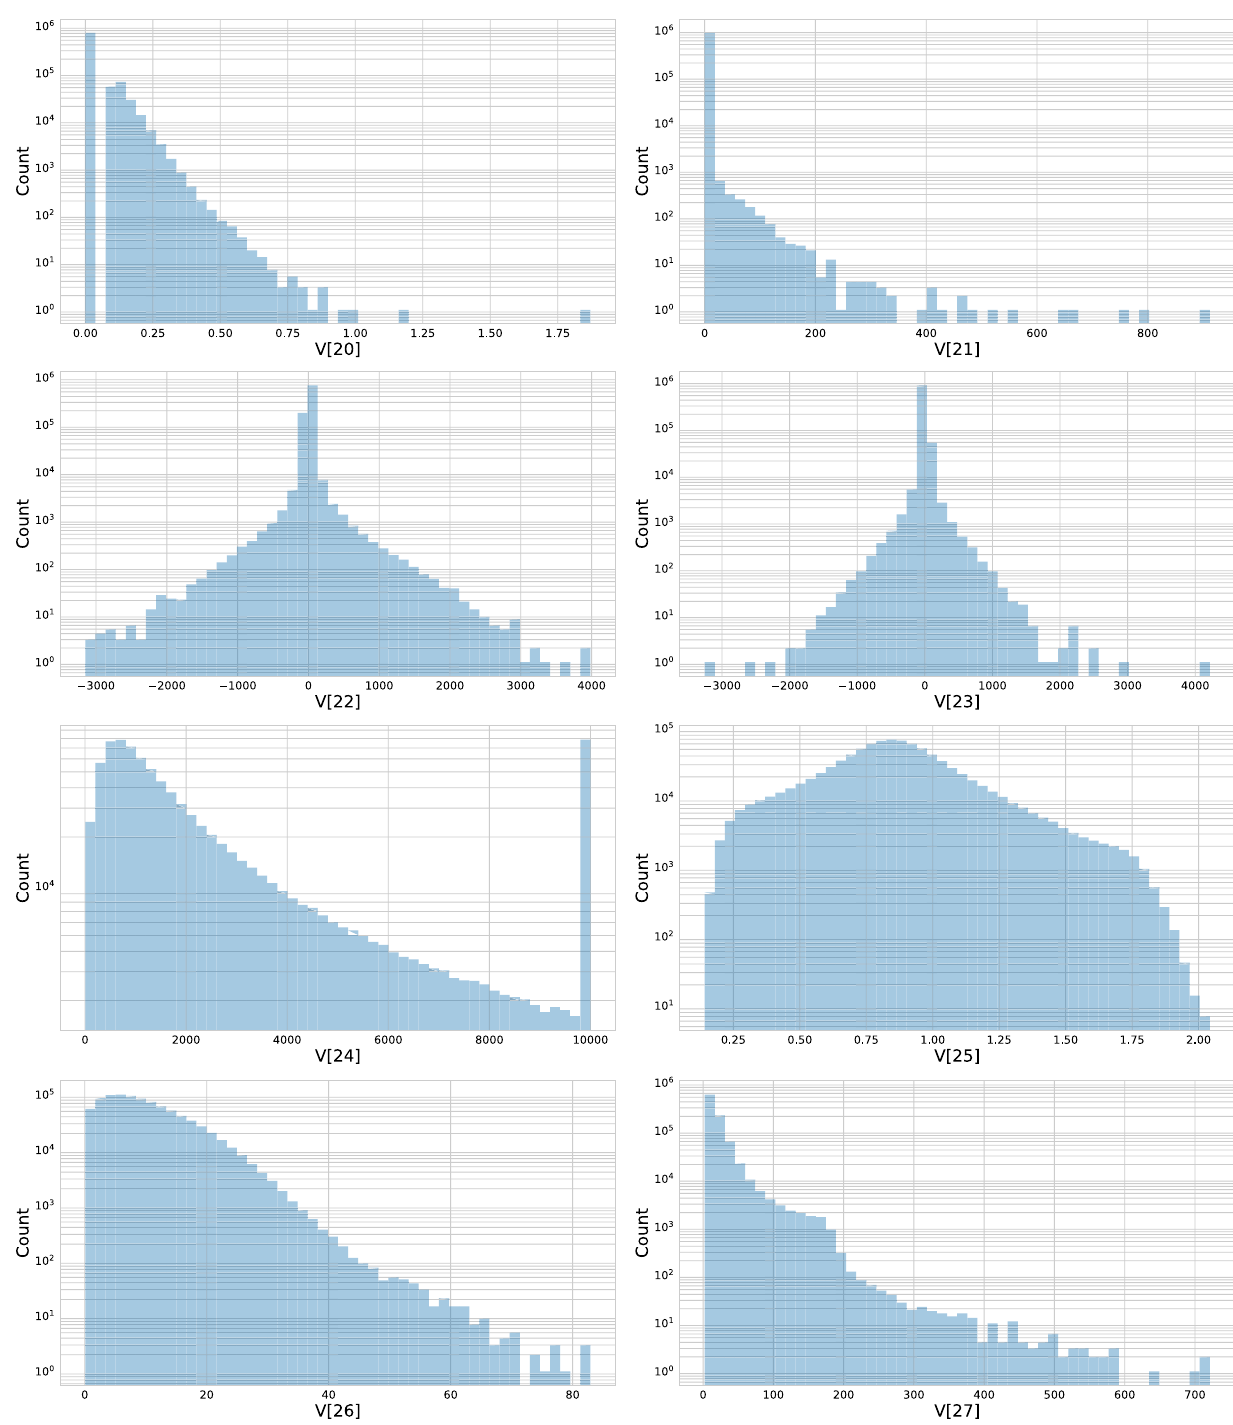
Fig. 17 1D density-distributions of features V[20] to V[27]. Features are defined in Sect.